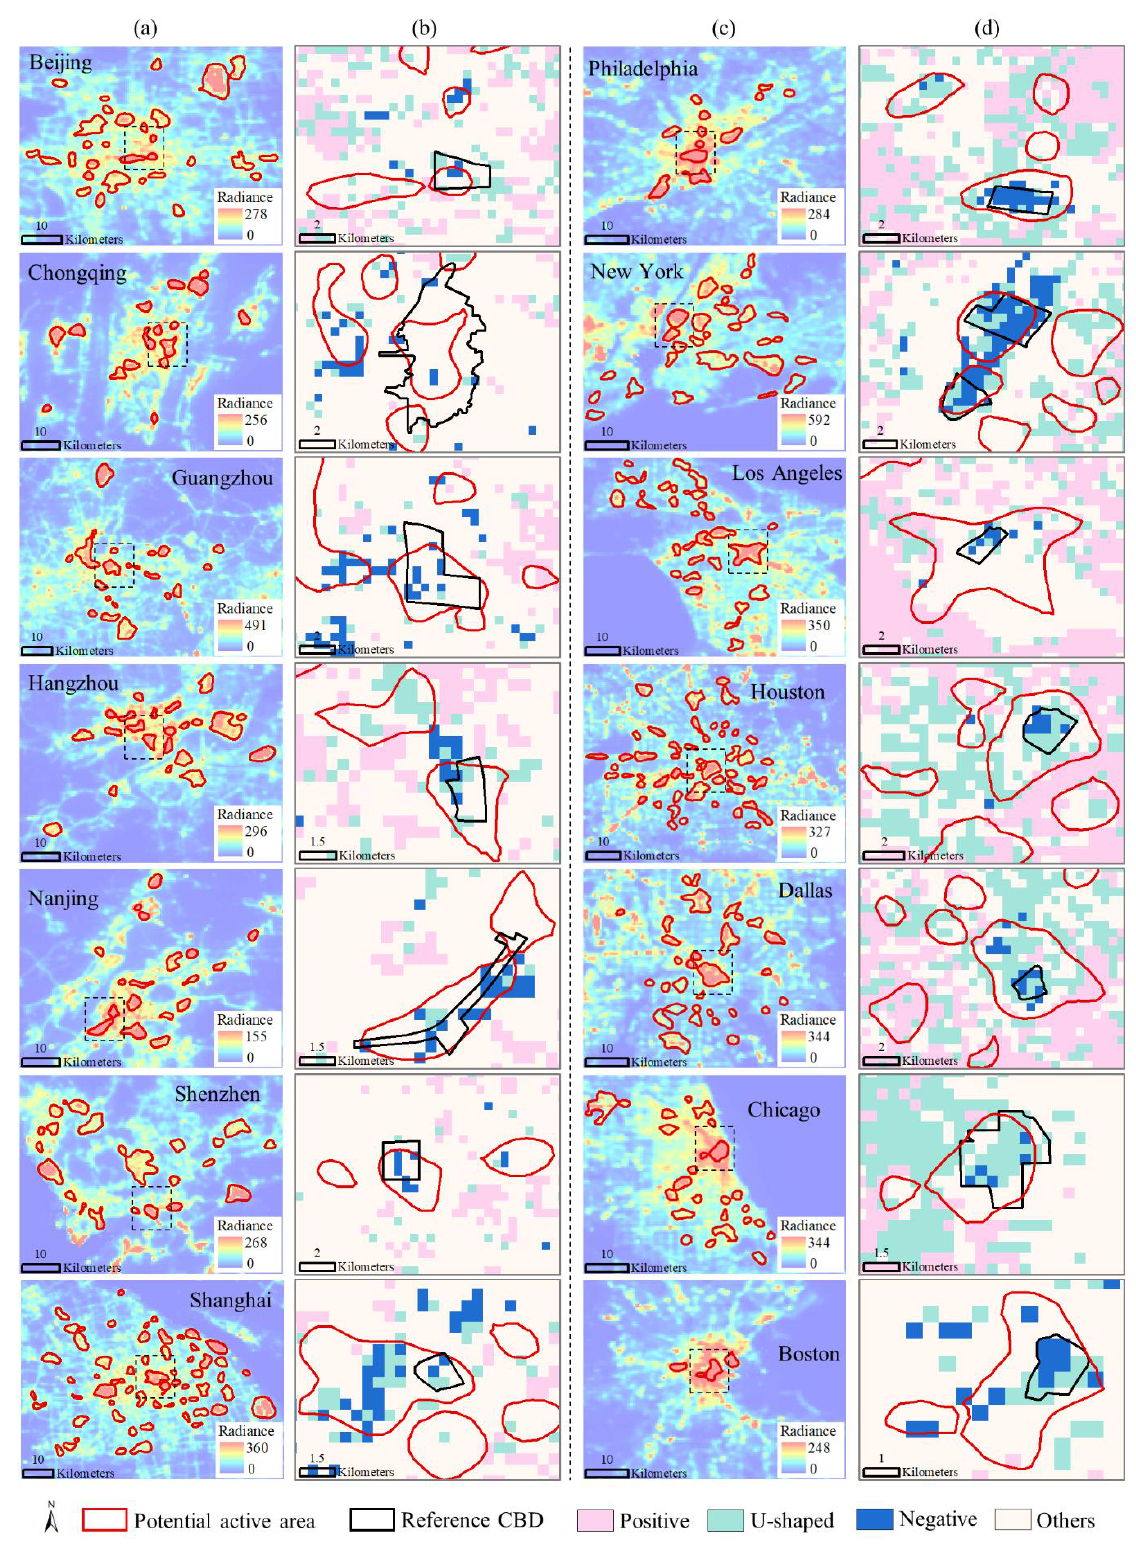
Figure 6. Distribution of PAAs and angular effects, where (b) and (d) are enlarged images of the black dashed boxes in (a) and (c), respectively. (a) Radiance distribution of Chinese cities and PAAs; (b) Distribution of angular effect near CBD of Chinese cities; (c) Radiance distribution of the U.S. cities and PAAs; (d) Distribution of angular effect near CBD of the U.S. cities.